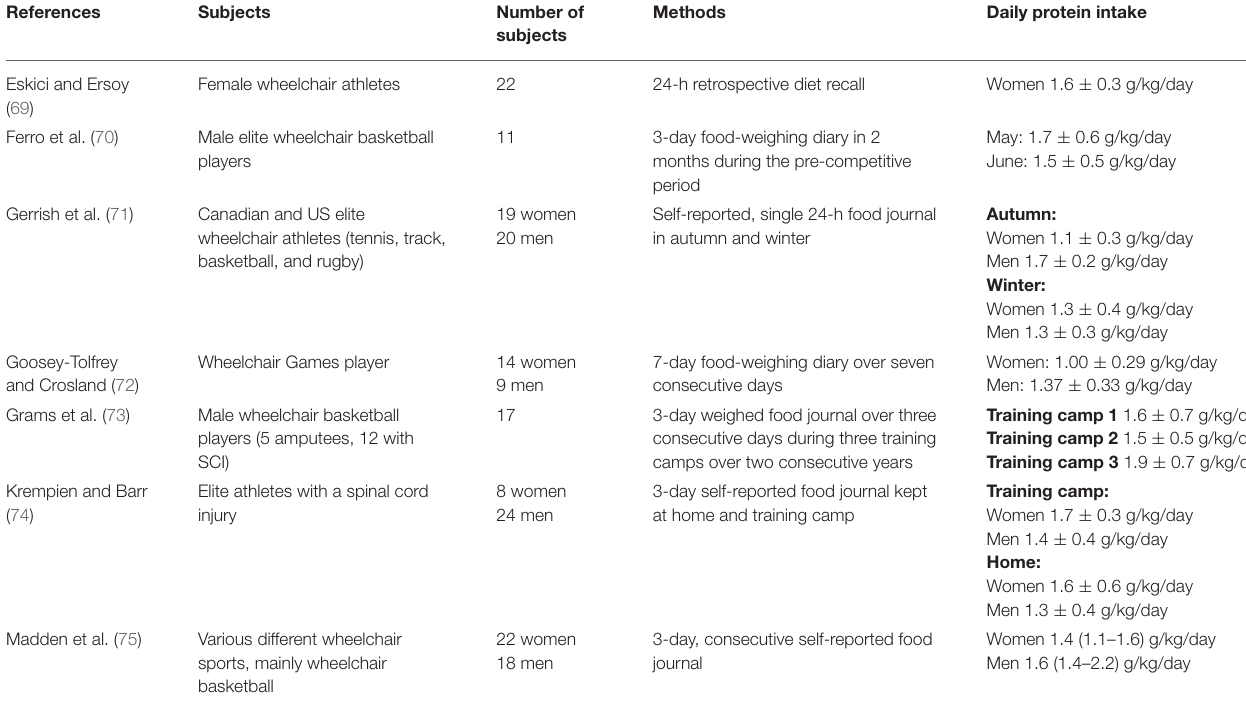
TABLE 2 | Protein intake in athletes with